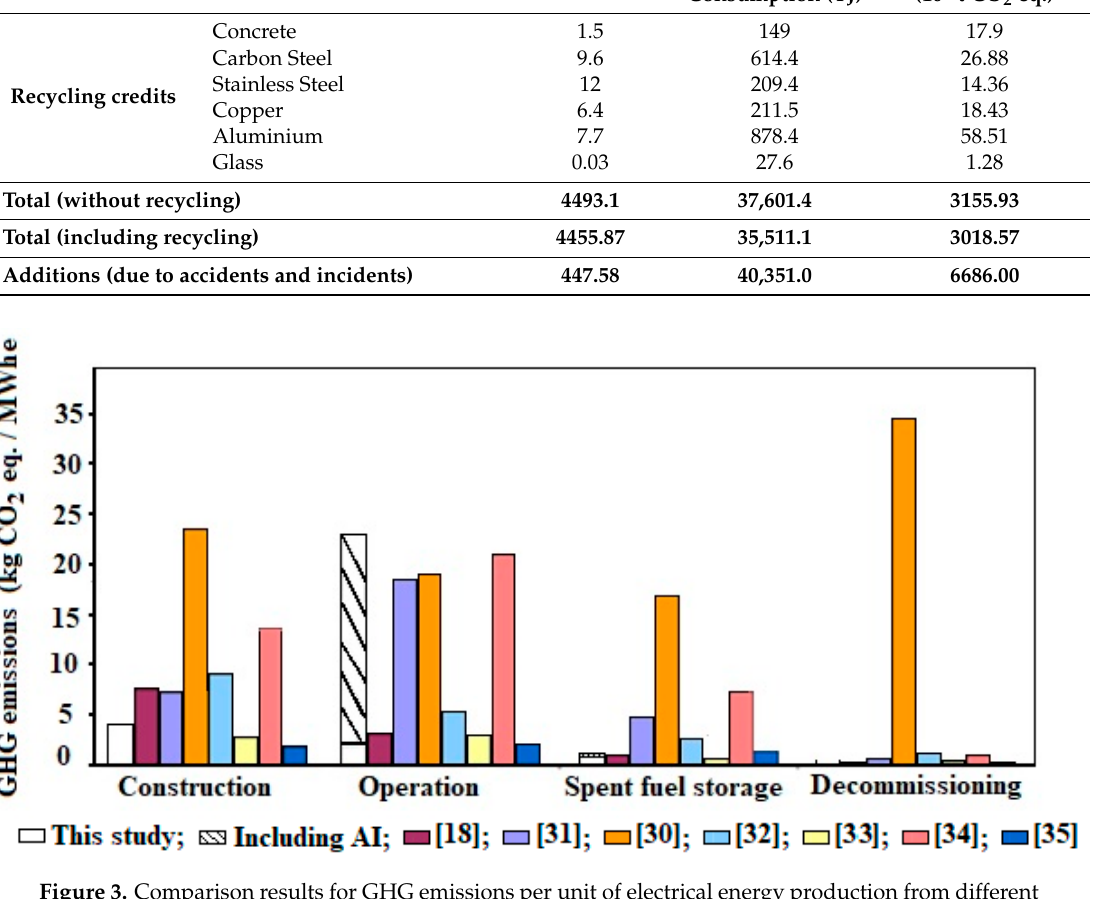
Figure 3. Comparison results for GHG emissions per unit of electrical energy production from different studies of nuclear power (NP) plant cycle: [18,30–35] and this study.